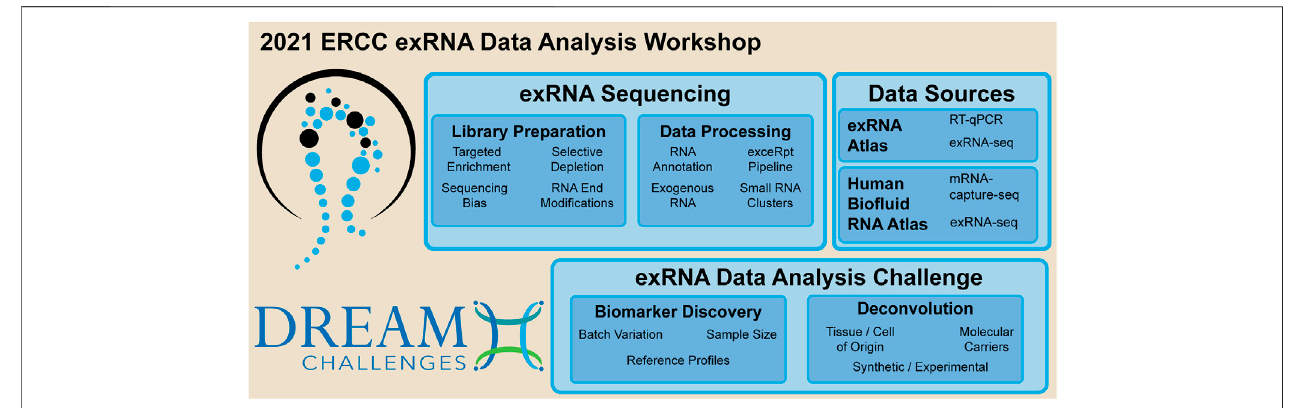
FIGURE 1 | Key topics discussed during the 2021 ERCC exRNA data analysis